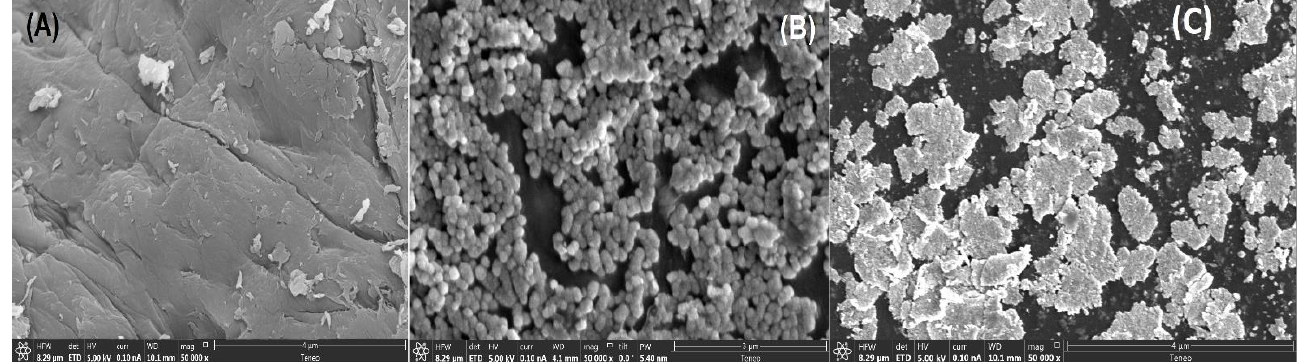
Figure 3. FESEM of chitosan ( A ), strontium oxide nanoparticles ( B ), and chitosan-SrO composite, 10 wt.% ( C ).